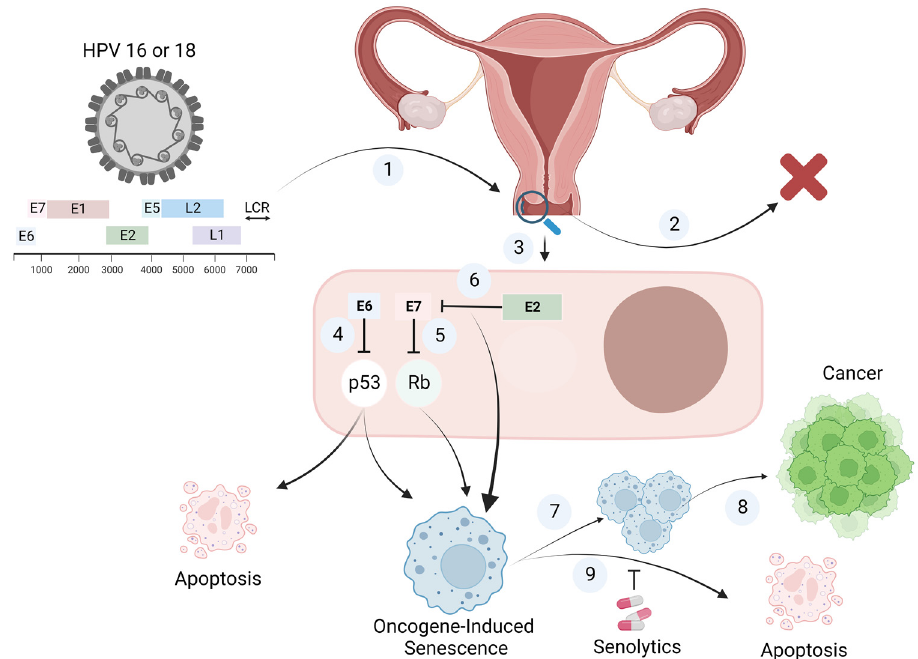
Figure 1. Proposed Model for The Contribution of HPV-Induced Senescence to Cervical Cancer. Oncogenic variants of the Human Papilloma Virus (HPV) infect basal squamous epithelial cells of the cervix 1 (cid:13) . Fortunately, the majority of infections resolve spontaneously and are cleared within two years 2 (cid:13) . however, approximately 1% of infected patients can develop cervical cancer 3 (cid:13) . The oncogenic potential of HPV is primarily attributed to the oncoproteins E6 and E7, which lead to the degradation/inactivation of the tumor suppressor genes p53 4 (cid:13) and 5 (cid:13) Rb, respectively. As a defense mechanism, several HPV-infected cells undergo apoptosis and are eliminated. Alternatively, cervical epithelial cells may undergo senescence as a tumor suppressor mechanism. Primarily, cells that have become dependent on E6- or E7-mediated suppression of cell cycle control can undergo senescence as a consequence to E2-mediated inactivation of E6 or E7 6 (cid:13) . Otherwise, when a naïve, virus-free cell is infected with HPV, cells undergo senescence, which is likely to represent an Oncogene-induced Senescence (OIS) variant. Oncogene-induced senescent cells infected with HPV accumulate as a component of the cervical premalignant lesion (CIN) being generated 7 (cid:13) . Only those cells that manage to escape OIS or those under constant pro-tumorigenic stimulation by the SASP, are capable of progressing into malignant phenotypes 8 (cid:13) . Alternatively, we propose the use of senolytics, compounds that selectively eliminate senescent cells, to interfere with the accumulation of premalignant senescent cells in cervical lesions, as a novel pharmacological approach to interfere with the development of HPV-induced cervical cancer 9 (cid:13)